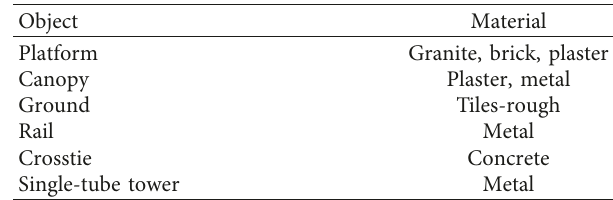
Table 1: Scenario composition.